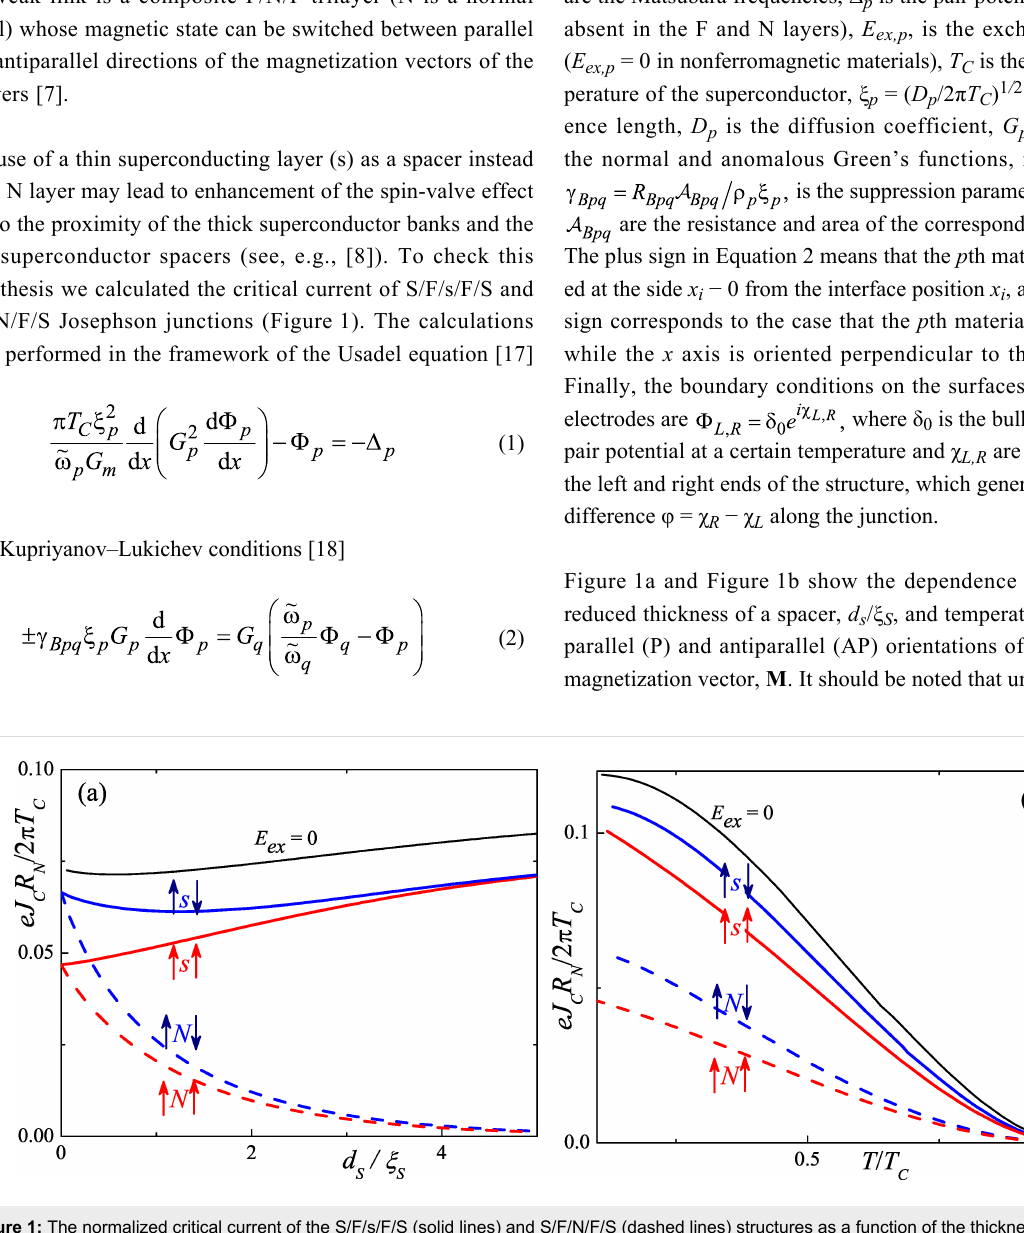
Figure 1: The normalized critical current of the S/F/s/F/S (solid lines) and S/F/N/F/S (dashed lines) structures as a function of the thickness of the spacing layer (a) and the dimensionless magnitude of the temperature (b). The red lines correspond to the case when the exchange energies in both layers of the ferromagnet are equal in magnitude, and the magnetization vectors lying in the plane of the magnetic layers are parallel (P). The blue lines are for the case when the exchange energies, E ex , in both F-layers are equal, and the described magnetization vectors are antiparallel (AP). The black curves correspond to the E ex = 0